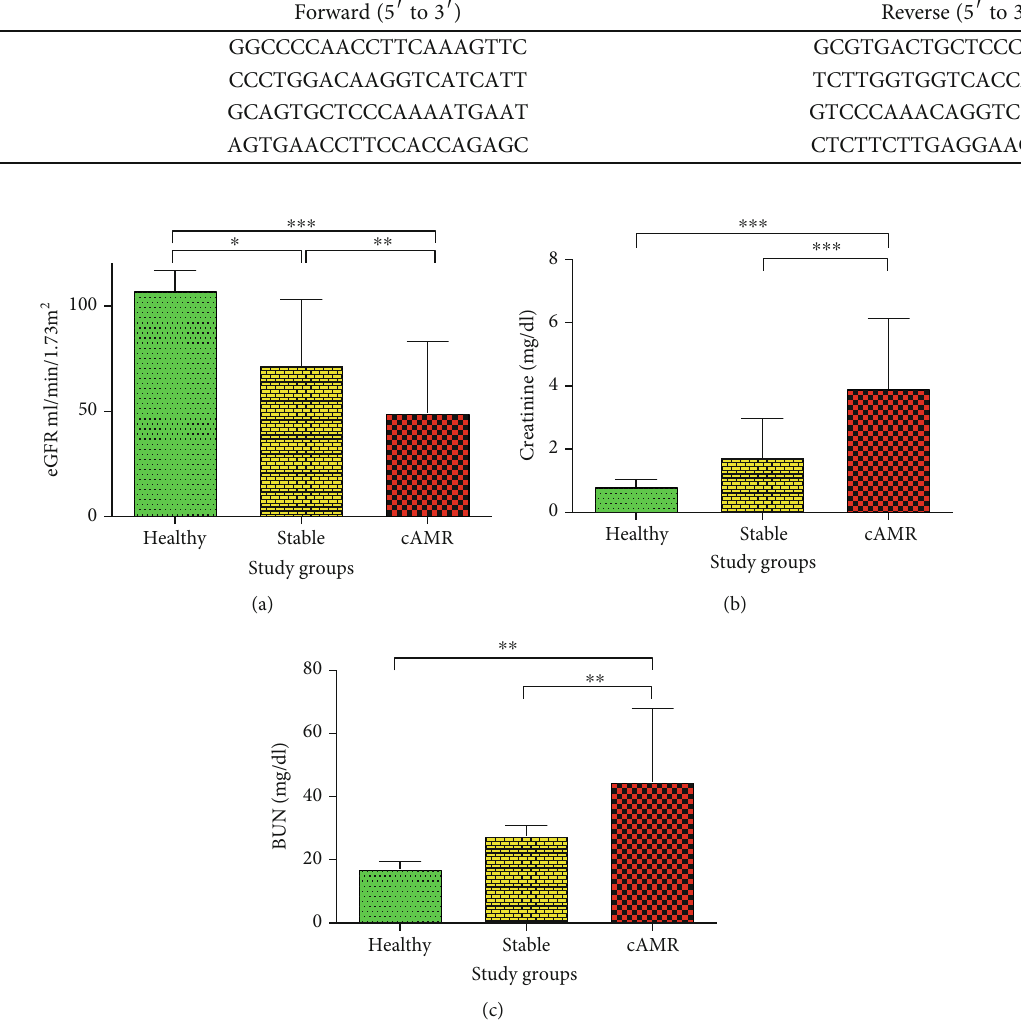
Figure 3: Renal function in the study groups. Estimated glomerular fi ltration rate (eGFR) (a), serum creatinine concentration (b), and blood urea nitrogen (BUN) (c) which used for evaluating the renal function are compared in healthy individuals, patients with stable graft function, and cAMR patients. Error bars represent SD ( ∗ P ≤ 0 : 05 , ∗∗ P ≤ 0 : 01 , ∗∗∗ P ≤ 0 : 001 ).